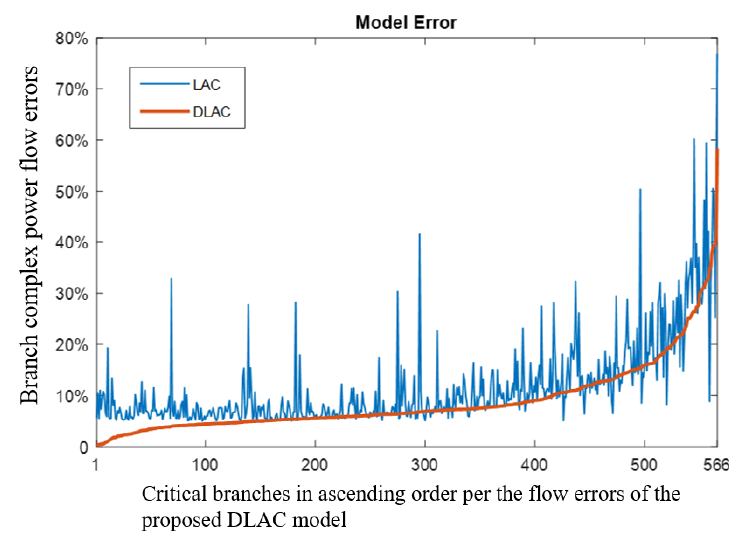
Figure 5. Branch complex power flow errors of LAC model and DLAC model for hour 2 case .